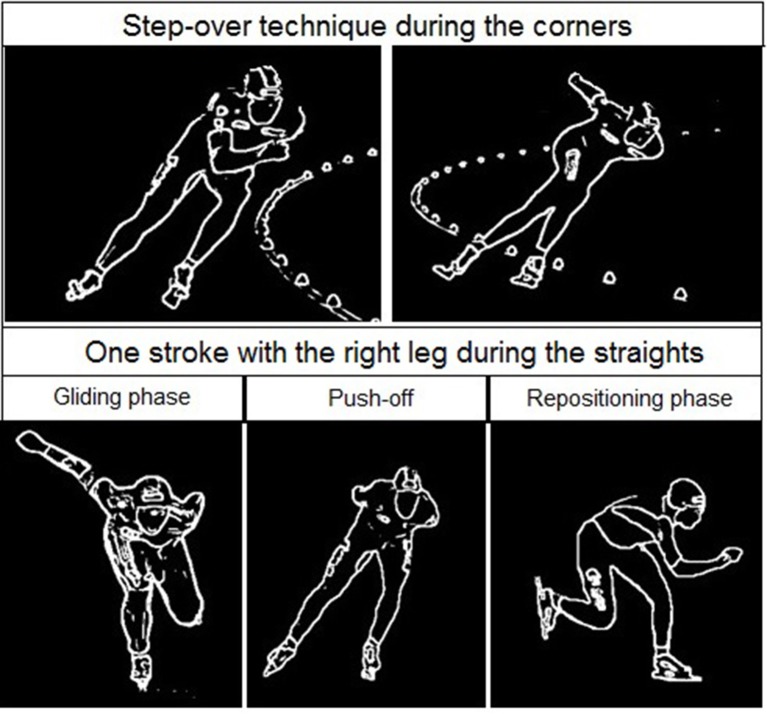
Skating at the corner (upper panel) and the straight (lower panel) in long track speed skating. The corner typically contains a series of leg crossovers. The straight is characterized by several strokes containing a gliding phase (left panel), push-off (middle panel), and repositioning phase (right panel) as shown in the lower figure for the right leg.